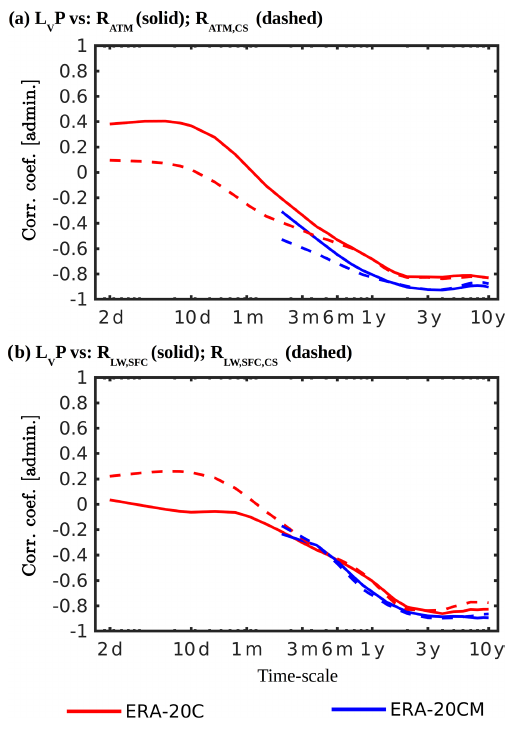
Figure 3. Cross-correlation coefficients against temporal scale computed from Haar fluctuations of (a) L v P vs. R atm (solid) and L v P vs. R atm , CS (dashed); (b) L v P vs. R LW , SFC (solid) and L v P vs. R LW , SFC , CS (dashed). Red lines are computed from ERA-20C and blue lines are from